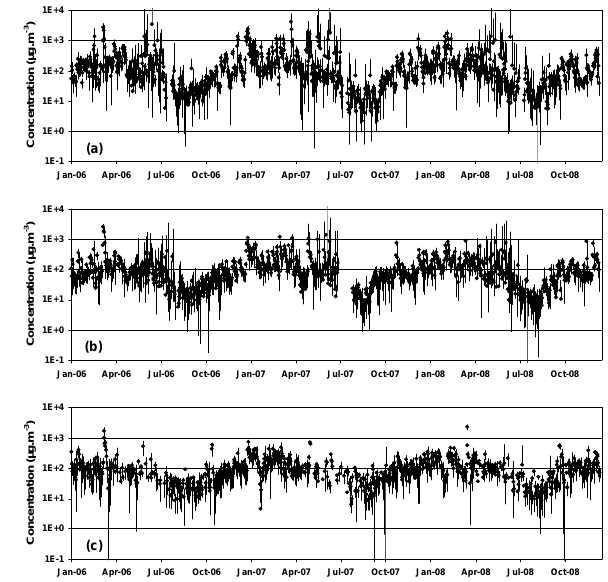
Fig. 3. Daily mean PM 10 concentration and standard deviation in Banizoumbou (a) , Cinzana (b) and M’Bour (c) for the selected “dust” wind